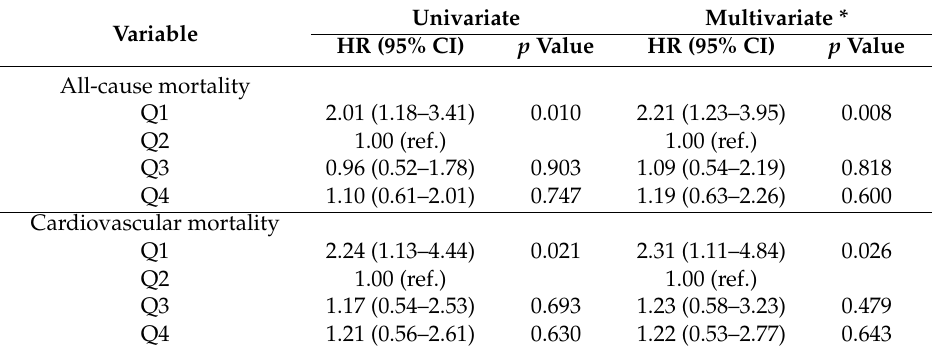
Table 4. Association between BMI change categories and all-cause and cardiovascular mortality.